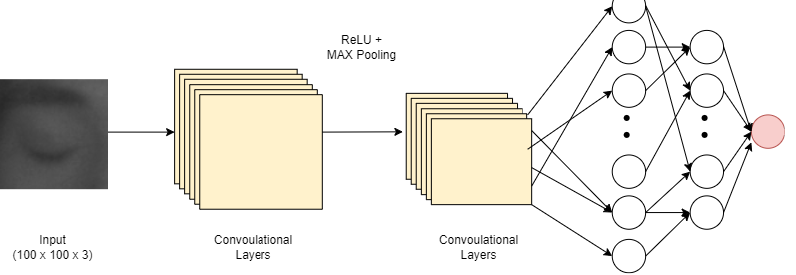
Figure 5. Convolutional neural